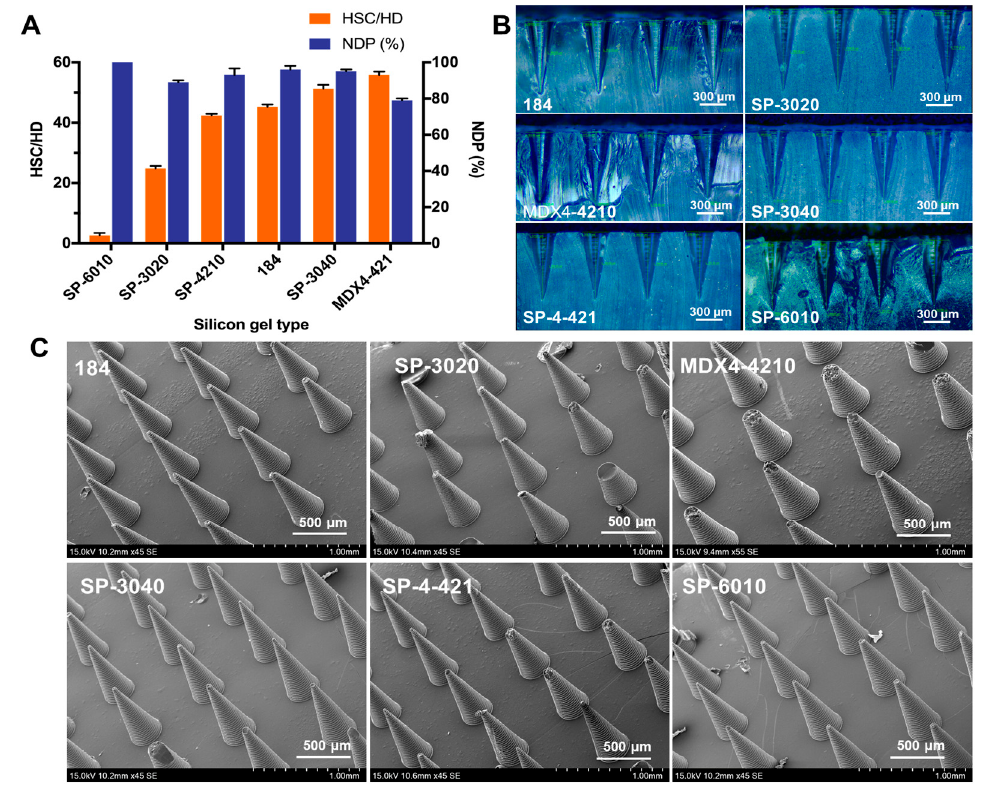
Figure 3. ( A ) The correlation between the Shore hardness of silica gel and the DNP of MNs ( n = 3). ( B ) The cross-sectional view of female molds prepared from different types of silica gel. ( C ) The SEM ( B ) The cross-sectional view of female molds prepared from di ff erent types of silica gel . ( C ) The images of MNs prepared by different female mold preparation SEM images of MNs prepared by di ff erent female mold preparation material.